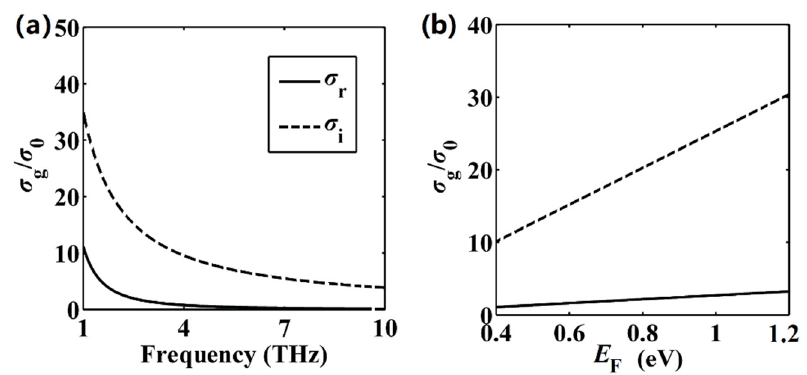
Figure 2. Graphene conductivity σ g normalized by σ 0 = e 2 / ћ based on Equations (3) and (4). Real and imaginary parts of σ g as functions of the ( a ) frequency and ( b ) Fermi energy level. E F = 0.5 eV for ( a ), f = 3 THz for ( b ).